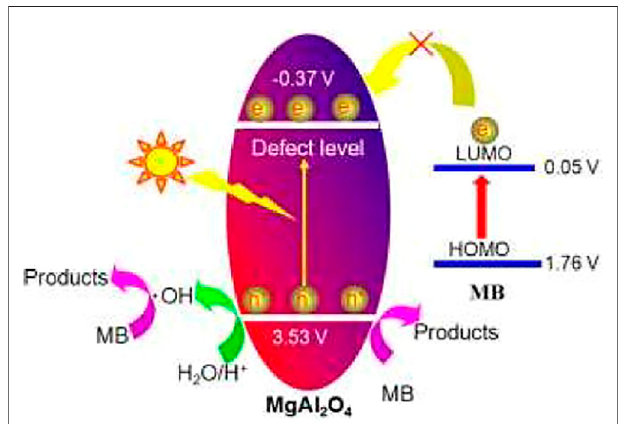
FIGURE 4 | Photocatalytic mechanism of MgAl 2 O 4 photocatalyst (Qian et al., 2017). Adapted from ref. (Qian et al., 2017). Copyright © 2017 Royal Society of